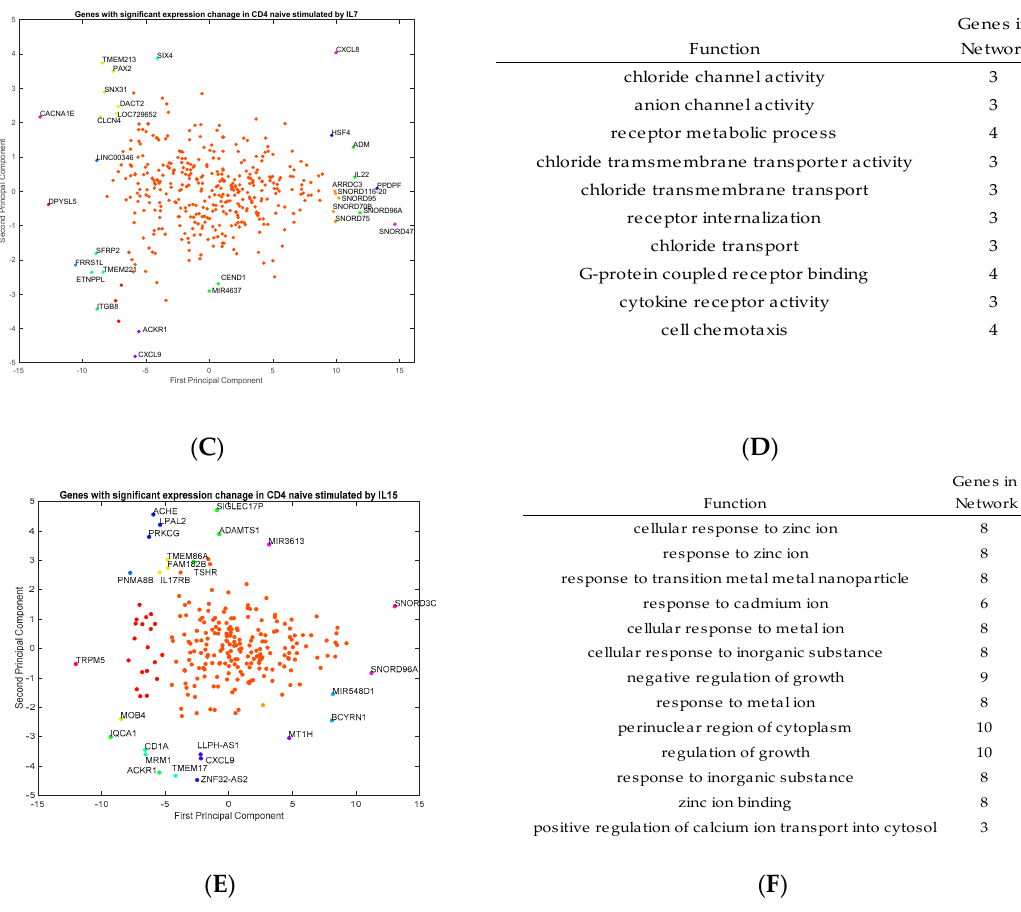
Figure 4. Principal component analysis (PCA) projections of genes with significant expression change by IL-2 ( A ), IL-7(C) and IL-15 ( E ) stimulation, with corresponding and respective gene function of IL-2 ( B ), IL-7 ( D ), and IL-15 ( F ) in activated CD4 + T cells. IL2 mainly regulated genes related to cell and leukocyte chemotaxis, chemokine receptor activity, cellular defense response and cell motility, while IL7 regulated genes involved in chloride transport, cell chemotaxis, chloride transmembrane activity, and cytokine receptor activity. The genes regulated by IL15 were involved in cell growth, zinc ion responses, cellular response to metal ions, and regulation of calcium ion transport into the